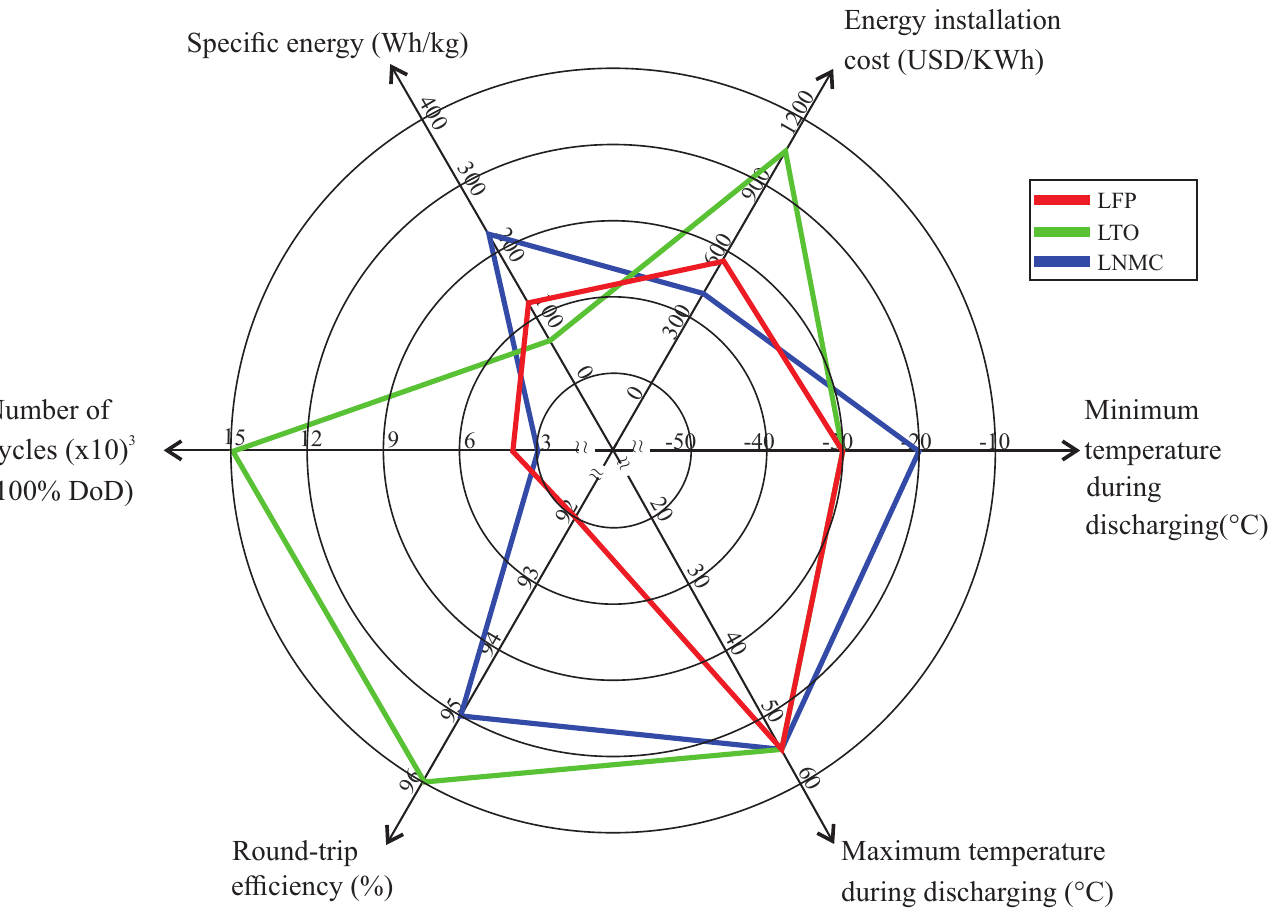
Figure 4. Comparison of LFP, LTO, and LNMC considering Maximum and Minimum Temperature of Operation [36], Energy Installation Cost [37], Specific Energy [38], Number of Cycles [36], and Round-trip Efficiency [37]. The number of cycles is considered to be the number of charges and discharges that will reduce the battery capacity to 80% of its rated capacity. The values for Minimum and Maximum Temperatures, Round-trip Efficiency, and Number of Cycles do not start from 0 because of graphical